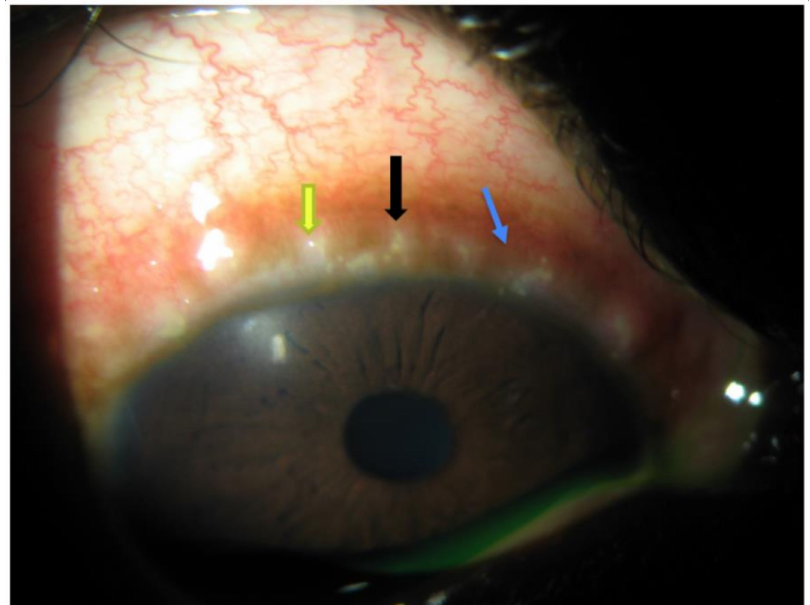
Figure 3. Limbal form of VKC characterized by the presence of gelatinous limbal papillary hyperpla- sia (black arrow), Horner-Trantas dots (yellow arrow), and perilimbal conjunctival hyperpigmentation (blue